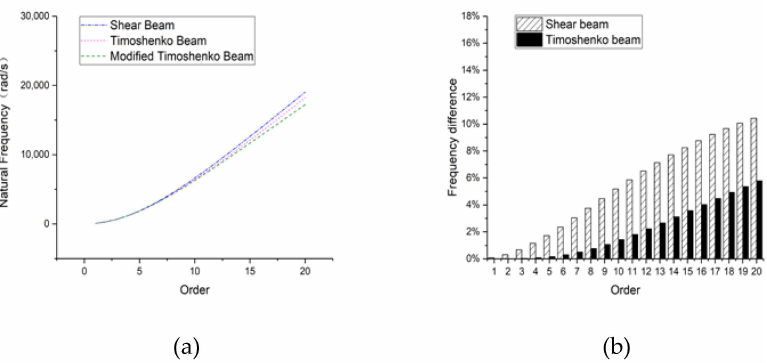
Figure 22. Natural frequencies of the 8-m-long beam: ( a ) overall frequency curve and ( b ) frequency di ff erence compared with a modified Timoshenko beam.